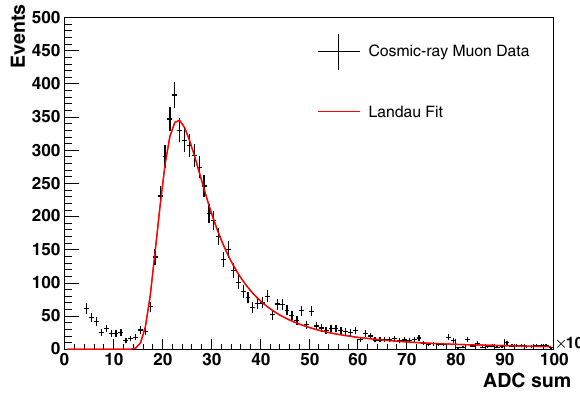
Fig. 9 The summed charge spectrum of muon-like events in one of the top-sidepanelsfor48.3daysofinitialdataintheCOSINE-100detector. The solid curve is the result of a fit to the spectrum with a Landau function. Events with ADC sum below 14,000 counts are primarily due to γ -ray-induced